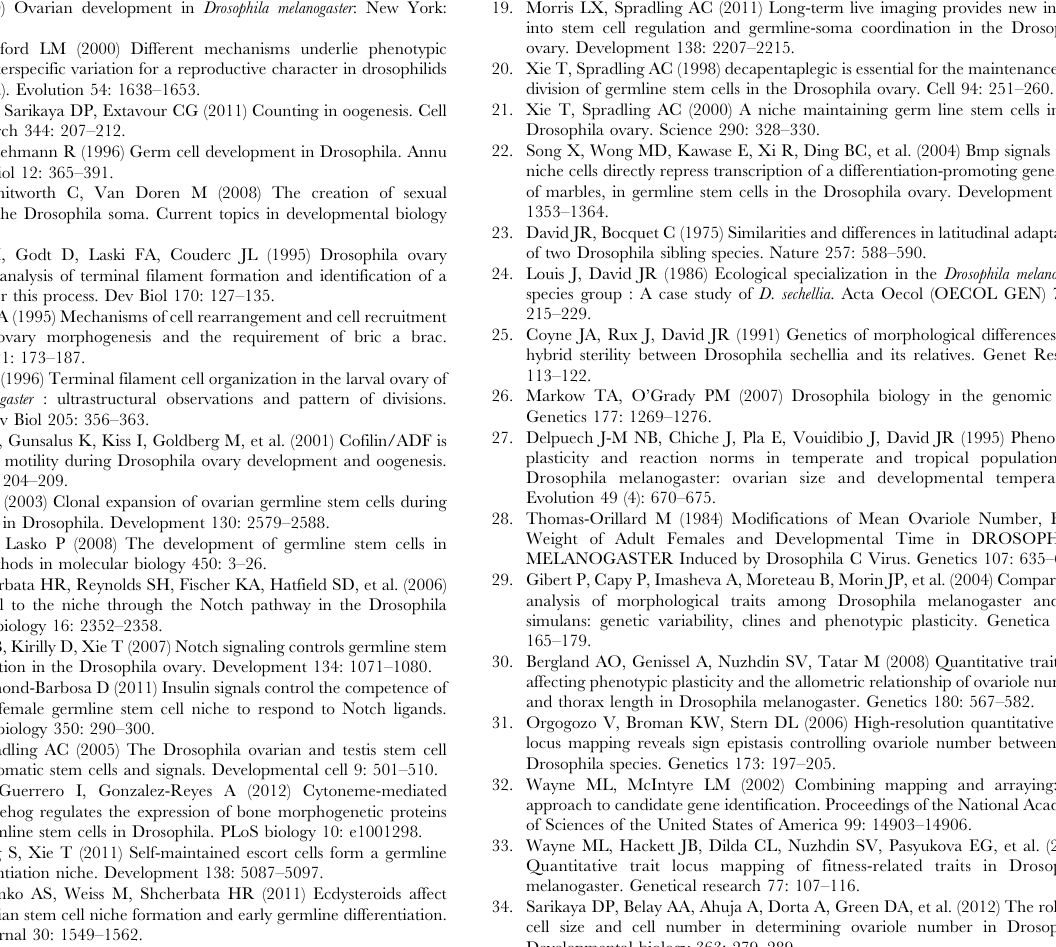
Table S4 Statistical significance for comparisons of cellular parameters between pupal or adult ovaries between heterozygous combinations of bab and psq